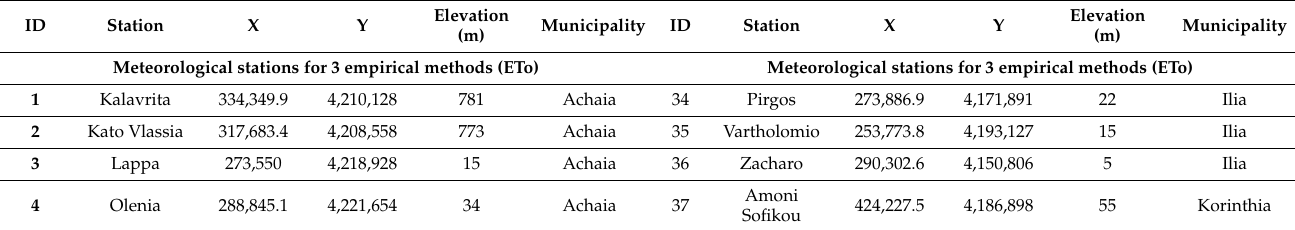
Table A1. Stations for testing of empirical methods (62) (https://meteosearch.meteo.gr (accessed on 16 January 2021)) and Epan measurements